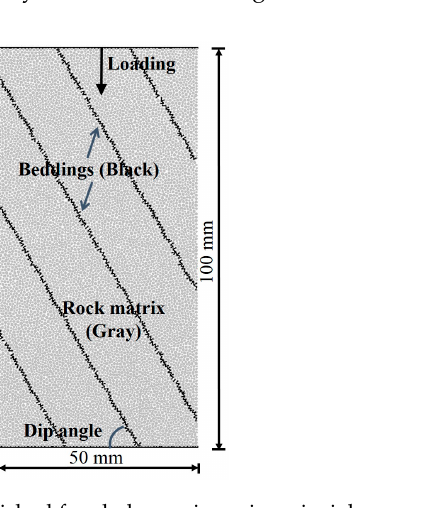
Figure 1. A numerical model established for shale specimen in uniaxial compression